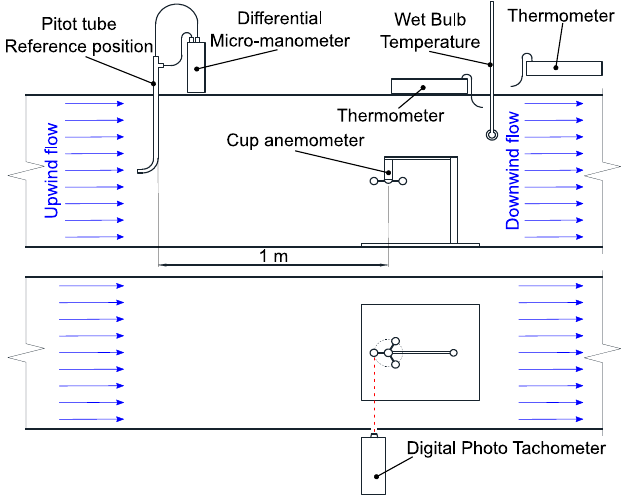
Figure 4. Schematic diagram of the experimental setup. Upper: front view. Lower: top view.